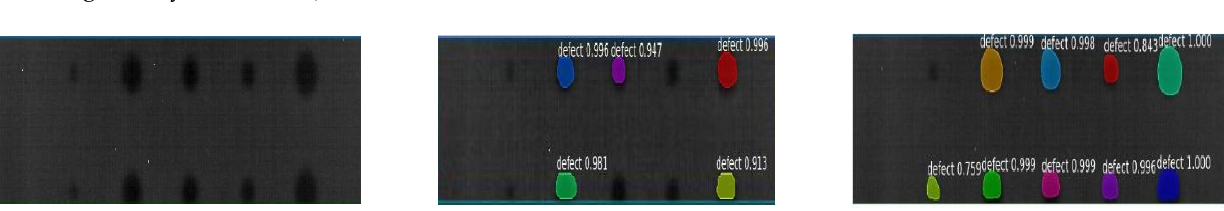
( c ) Example 3 from plexiglass specimen (left: ground truth; middle: training without synthetic data; right: training with synthetic data)